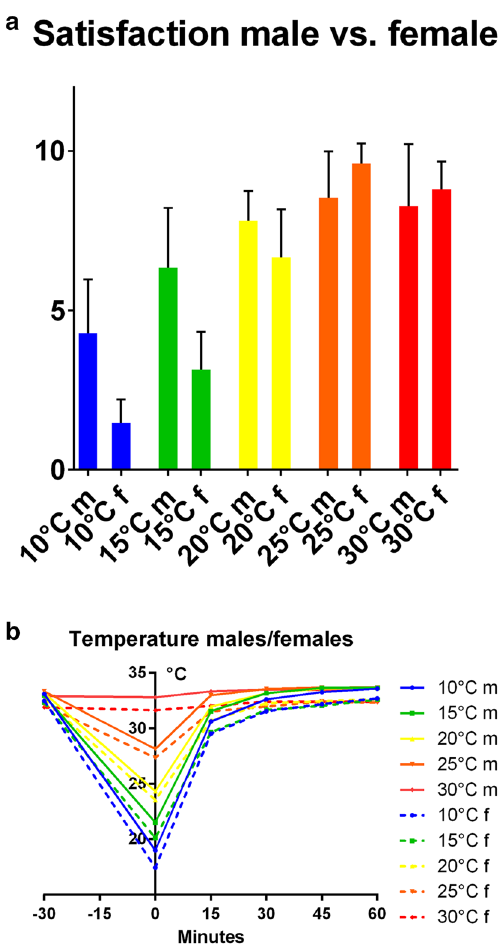
Figure 3. ( a ) Participants’ satisfaction with cooling temperatures, ( b ) females’/males’ measured skin temperature [°C].